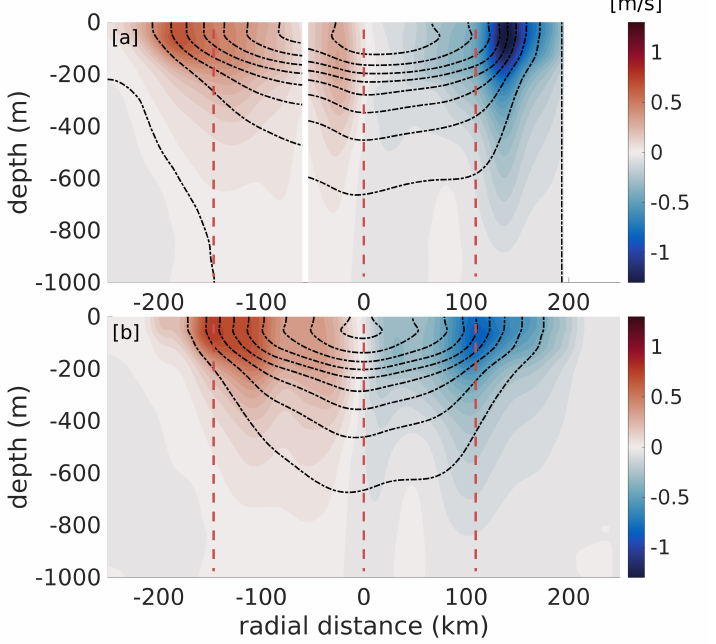
Figure 9. Comparison of the uncorrected ( a ) panel and corrected ( b ) panel LCR’s geostrophic velocity fields. The uncorrected geostrophic velocity is directly computed from the glider observations using the distance traveled by the glider as an horizontal coordinate to compute density gradients. The corrected geostrophic velocity field is computed using the relocated glider dives positions. The red dotted lines represent the location of the velocity maxima in relocated